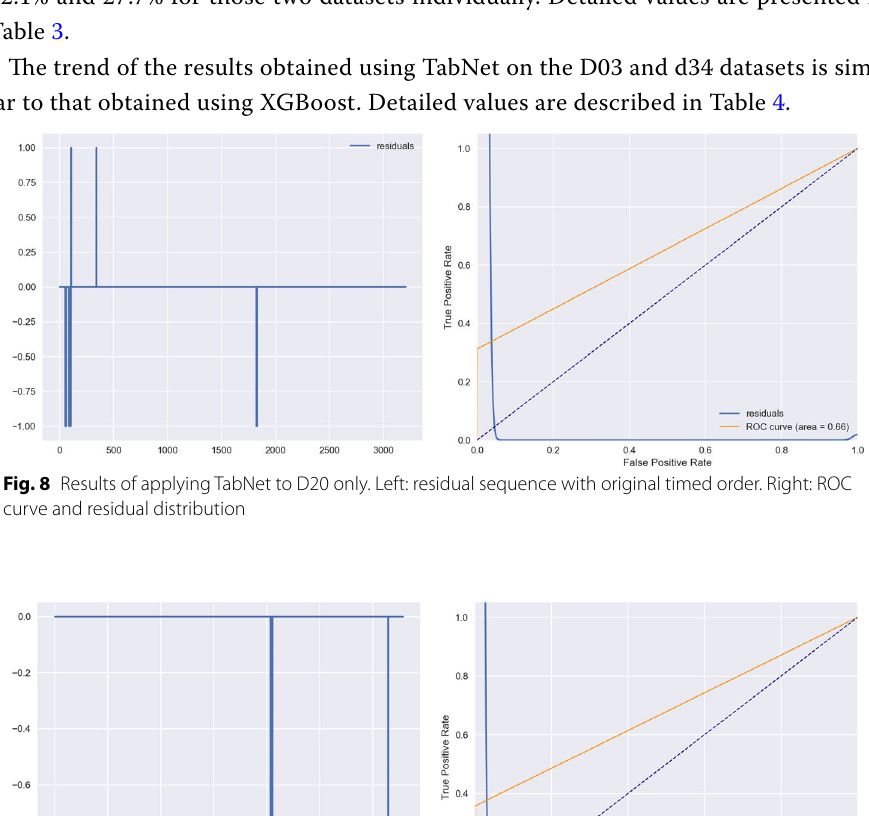
D21. Left: residual sequence with original timed order. Right: +